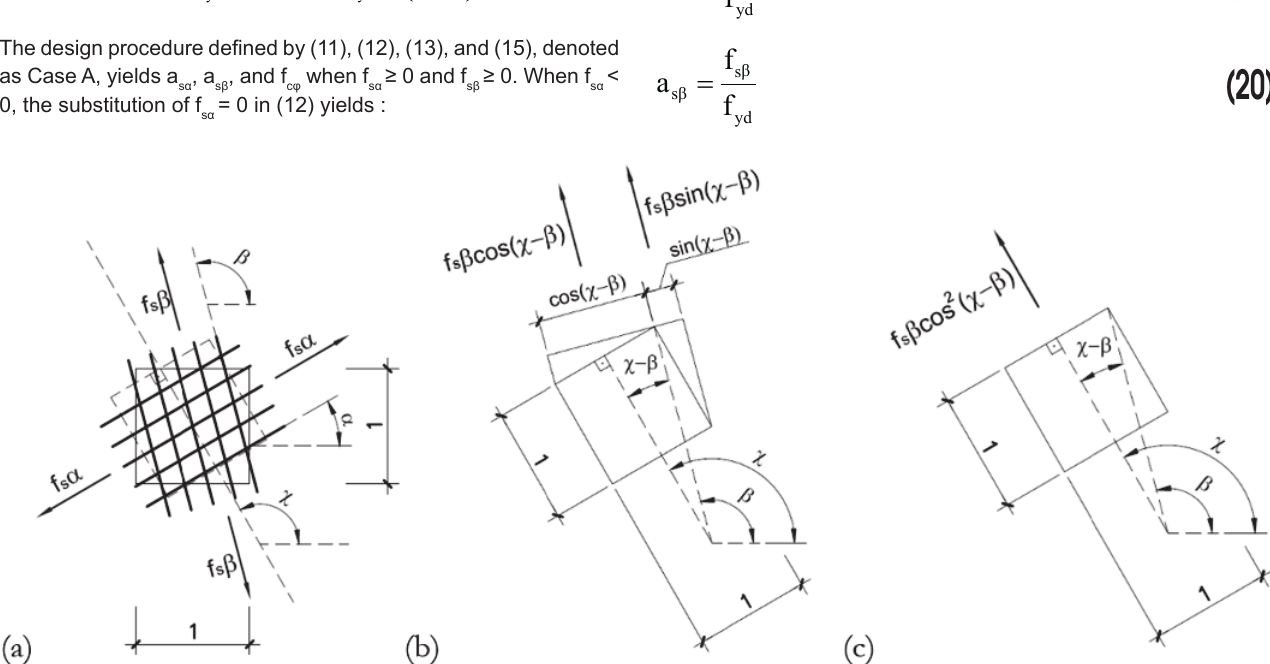
Figure 5 (a) Steel forces in directions